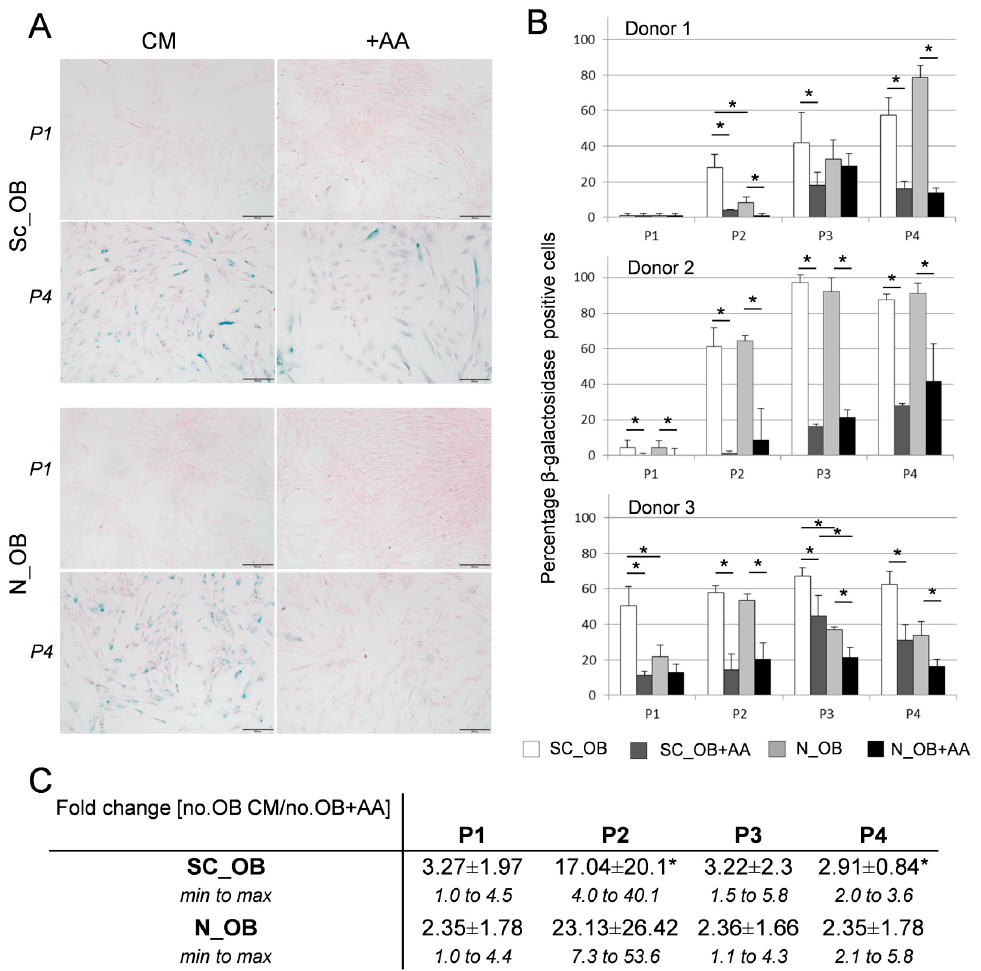
Figure 2. Effect of AA on cell senescence. ( A ) Senescent Sc_OB and N_OB were stained blue by senescence specific β -galactosidase staining at P1 and P4 (representative pictures shown for donor 1). Cells were counterstained with Nuclear Fast Red; scale bar = 200 µm ( B ) Quantification of positively stained cells versus the total amount of osteoarthritic OB in percentage, for three individual donors (donors 1–3, values are means (±SD) of four observed fields per experimental group); * indicates statistically significant differences ( p < 0.05) between the displayed conditions and cell sources at each passage. ( C ) Indication of the x-fold higher expression (mean ± SD) of senescent cells in CM as compared to the same cells expanded with AA (percentage of senescent cells in CM/percentage of senescent cells in the presence of AA), with minimal and maximal fold-changes indicated; * indicates statistically significant differences ( p < 0.05) between culture conditions for each cell type, n = 3 donors.